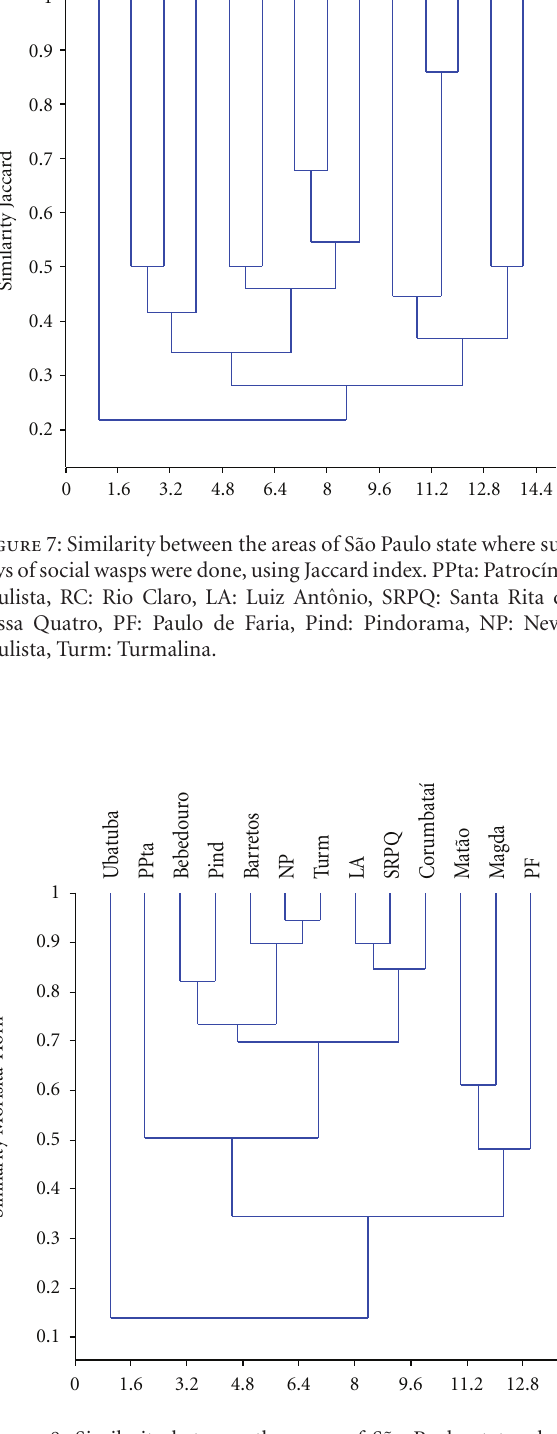
Figure 8: Similarity between the areas of S˜ao Paulo state where surveys of social waspswere done, using Morisita-Hornindex. PPta: Patroc´ınio Paulista, Pind: Pindorama, NP: Neves Paulista, Turm: Turmalina, LA: Luiz Ant ˆ onio, SRPQ: Santa Rita do Passa Quatro, PF: Paulo de Faria.